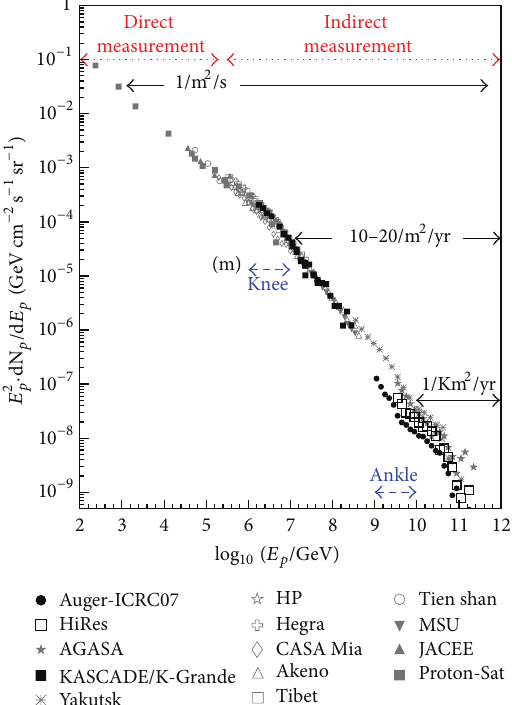
Figure 2: At the energies of interest here, the cosmic-ray spectrum follows a sequence of 3 power laws. The first 2 are separated by the “knee,” the 2nd and 3rd by the “ankle.” Cosmic rays beyond the ankle are a new population of particles produced in extragalactic